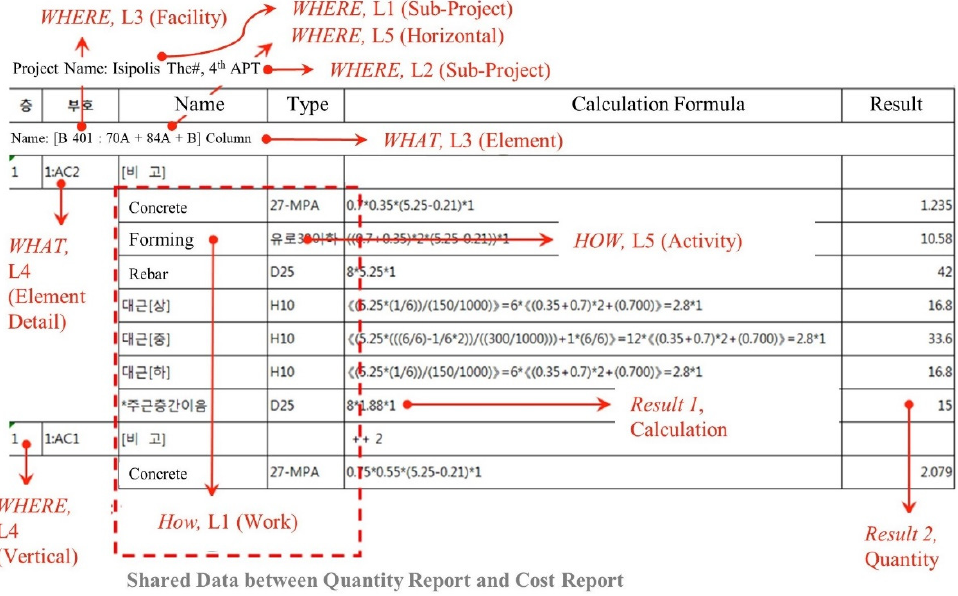
Figure 7. Data Extracting and Mapping from Quantity-takeoffs into the 5W1H Data Schema.